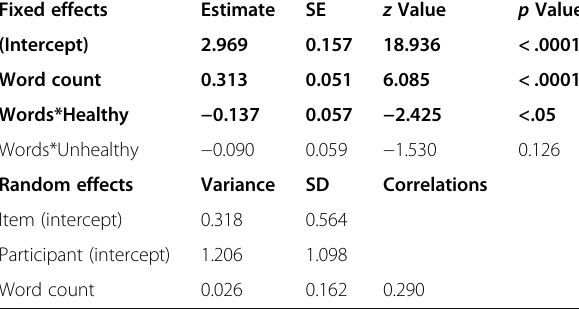
Table 2 Experiment 1: Effect of comment length on correct identification of old